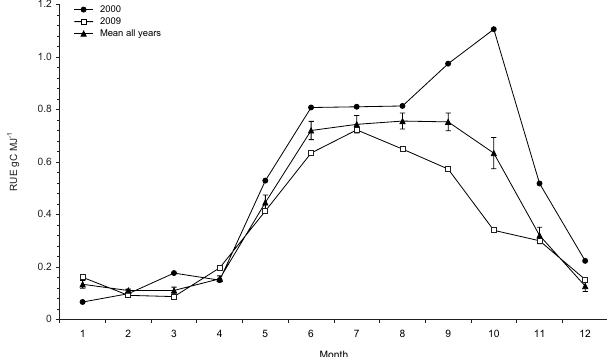
Fig. 9. Monthly RUE for contrasting years of high GPP (2000) and low GPP